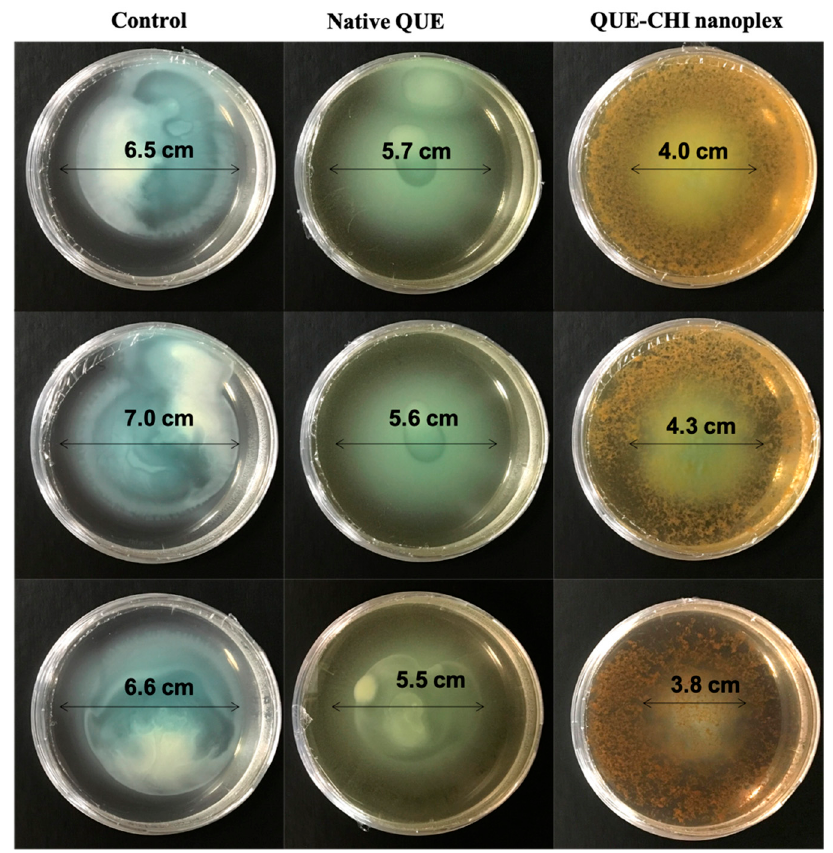
Figure 8. Swimming motility of P. aeruginosa in the presence of QUE (note: top, middle, and bottom panels represent the results from three independent replicates) .